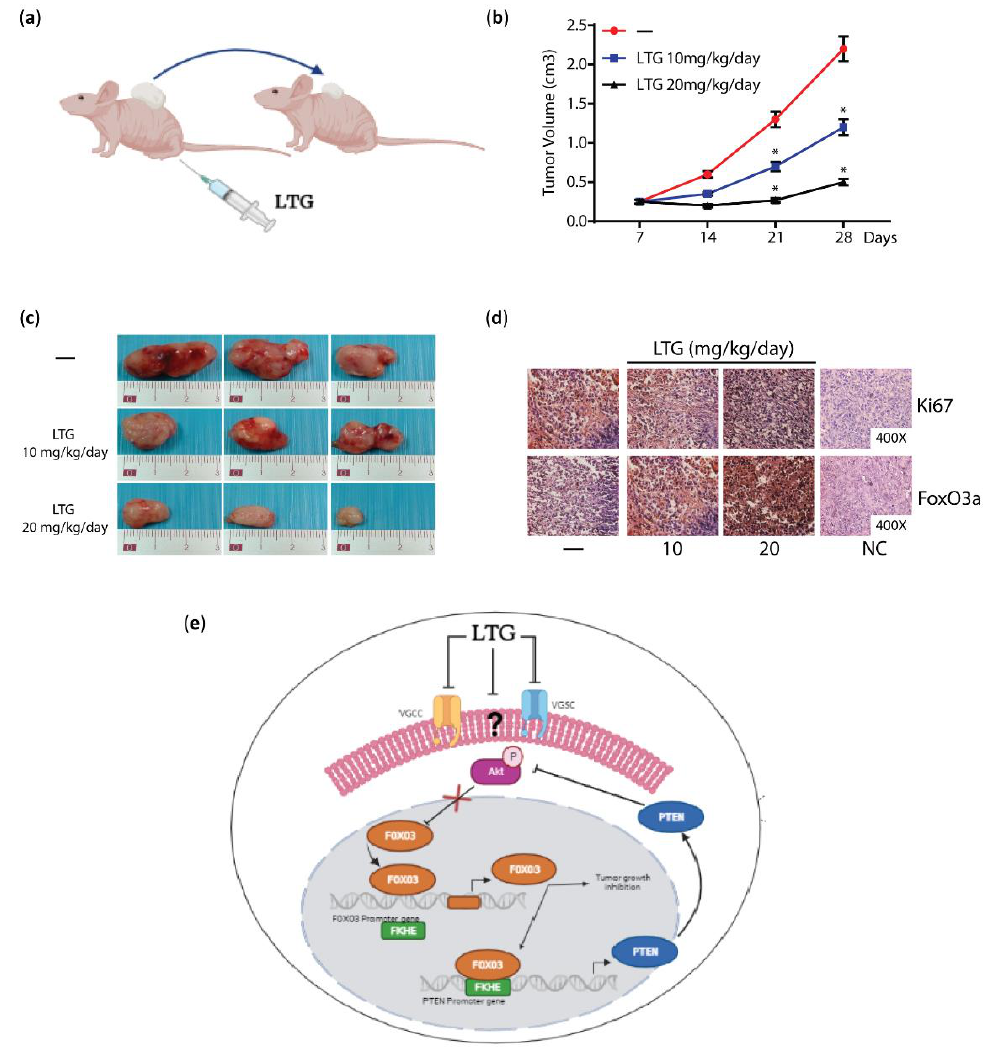
Figure 2. LTG inhibits BC tumor growth by inducing FoxO3a expression. ( a ) Mice bearing BCCs- derived xenografts were treated with LTG at 10 mg/kg/day and 20 mg/kg/day. ( b ) Tumor growth was monitored by caliper, measuring the visible tumor sizes at indicated time points. *, p < 0.05 versus control. ( c ) At the end of experiment, tumors were explanted and representative images are shown. ( d ) Ki67, a marker of proliferation index, and FoxO3a expression was evaluated in FFPE sections of tumor xenografts deriving from mice treated or not (-) with LTG. NC, negative control. ( e ) Schematic representation of LTG hypothetical mechanism of action in BC. LTG, by presumably blocking VGSCs and/or VGCCs or an unknown target, inhibits AKT signaling, activating its target FoxO3a, which induces its own transcription and expression and, consequently, the expression of its downstream target, PTEN, which, in turn, maintains inactive the PI3K/AKT pathway, thus sustaining an antiproliferative autoregulatory loop. Results and schemes shown here are adapted from Pellegrino M. et al.